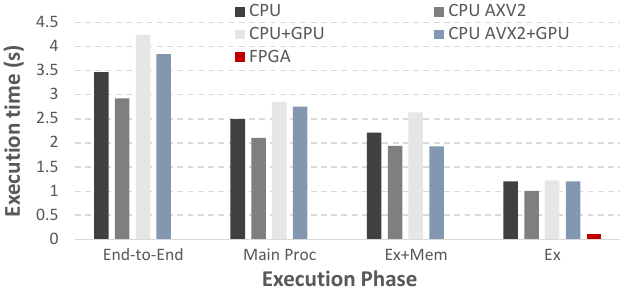
Figure 5. FPGA, CPU and GPU performance for the LeNet inference